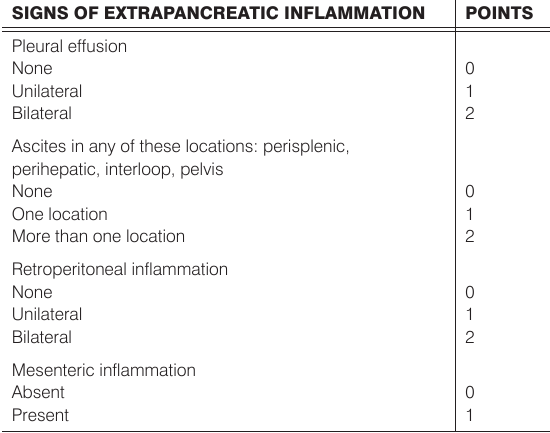
Table 3. CT severity index and patient outcomes using a modified CT severity index. [ 8 ] PROGNOSTIC INDICATOR POINTS